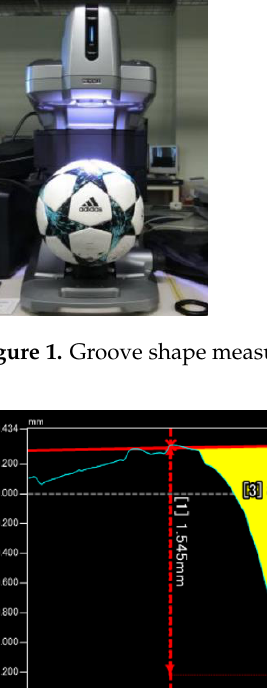
Figure 3. Fluid force measurement (back).